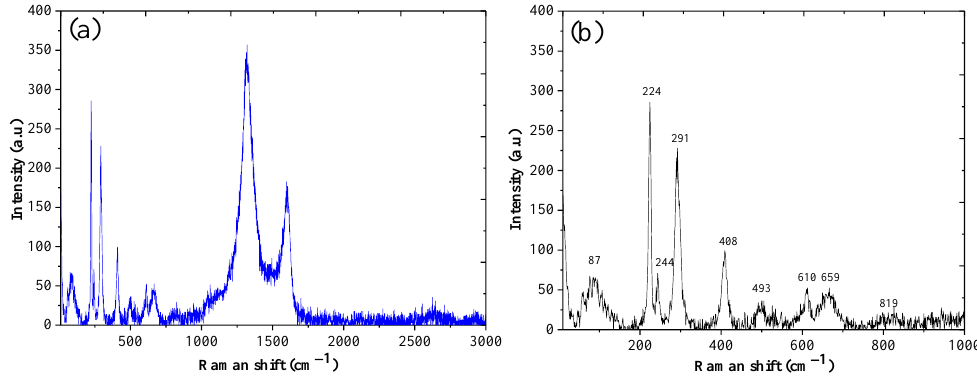
Figure 4. Raman spectra of MRGO ( a ); Magnification of Raman spectra of MRGO ( b ).